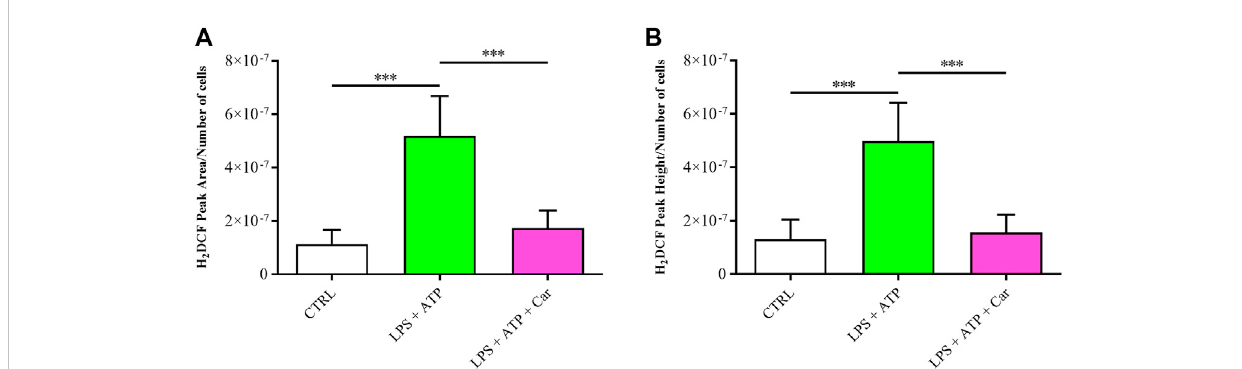
FIGURE 2 Detection of intracellular concentrations of ROS, expressed as (A) average peak area/number of cells or (B) average peak height/number of cells in restingHMC3cellsandinHMC3cellschallengedwithLPS(100 ng/mL,24 h)+ATP(5 mM,30 min),intheabsenceorpresenceofcarnosine(Car)(10 mM,